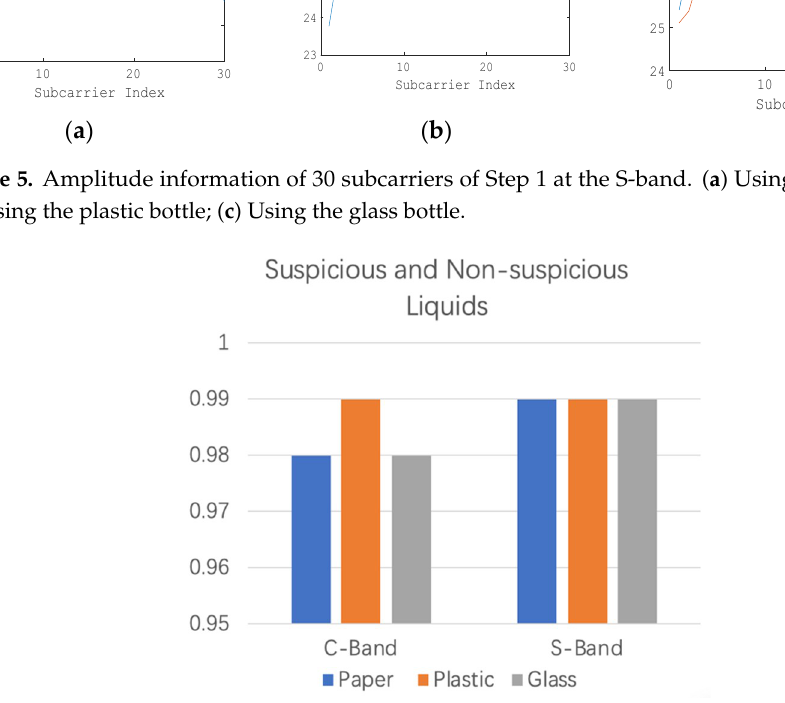
Figure 6. The KNN algorithm Classification results of Step 1 at the C-band and the S-band.